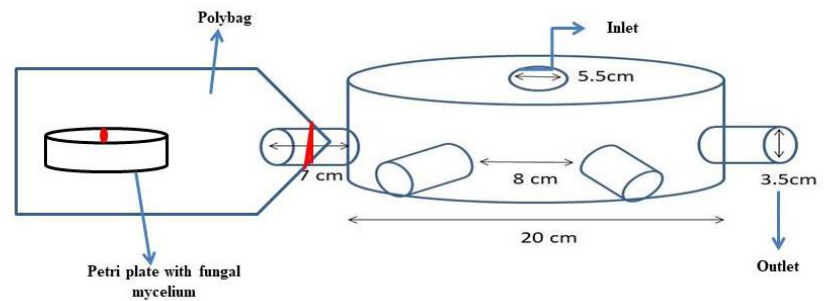
Figure 8. Model of olfactory chamber.